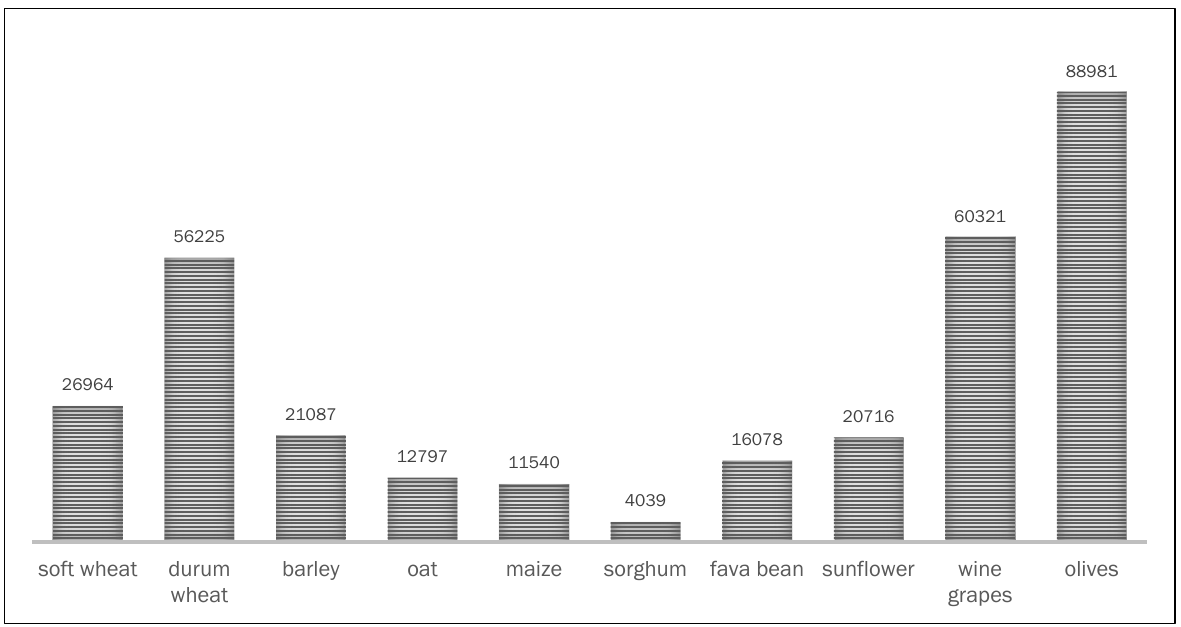
Figure 1. Top 10 Crops in Tuscany by Growing Area, 2020